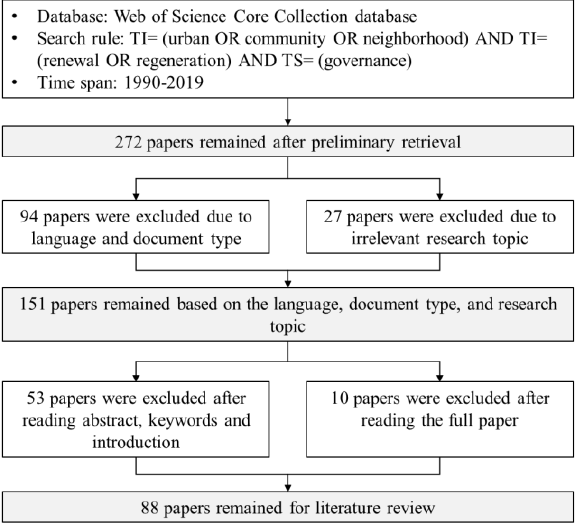
Figure 2. The flow of the screening process.